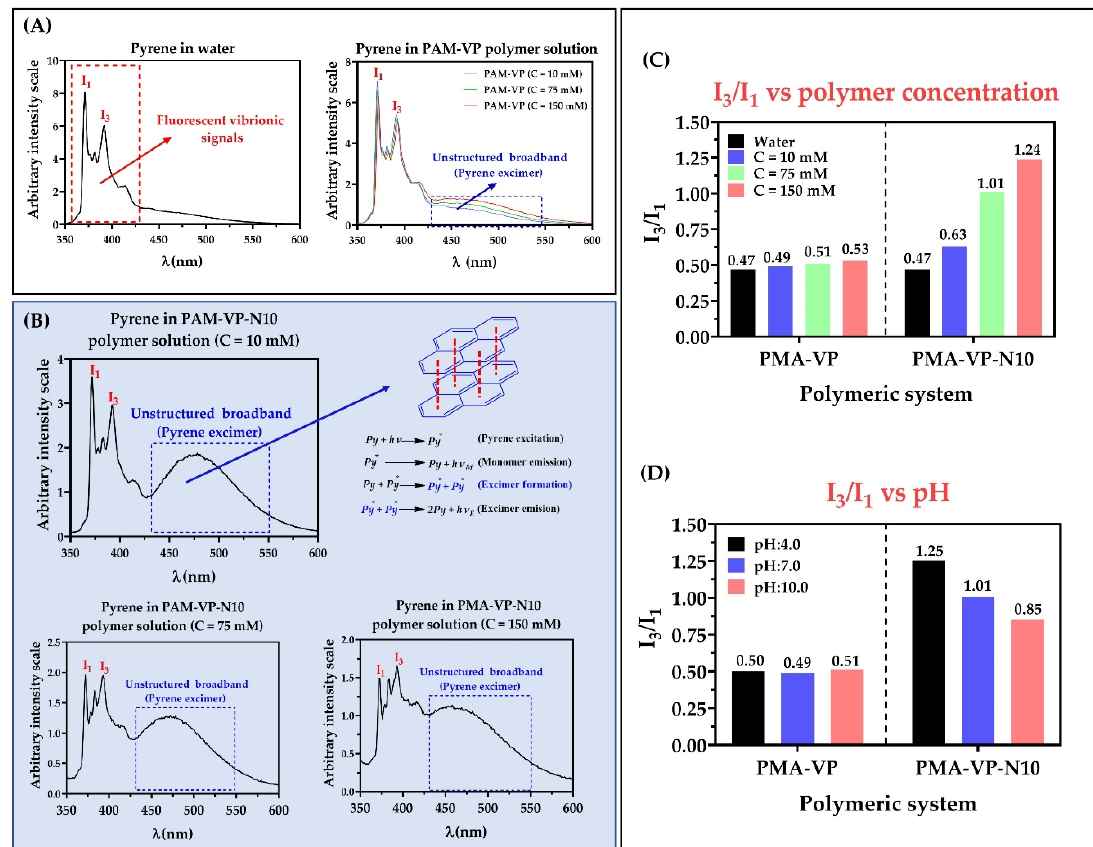
Figure 4. Fluorescence spectra of pyrene in aqueous solution of polymers ( A ) PMA-VP and ( B ) PMA-VP-10Na at pH: 7.0 and different polymeric concentrations. ( C ) I 3 /I 1 ratio of pyrene fluorescence as a function of polymer concentration at pH: 7.0 ( D ). I 3 /I 1 ratio of pyrene fluorescence as a function of pH at polymer concentration of 75 mM.